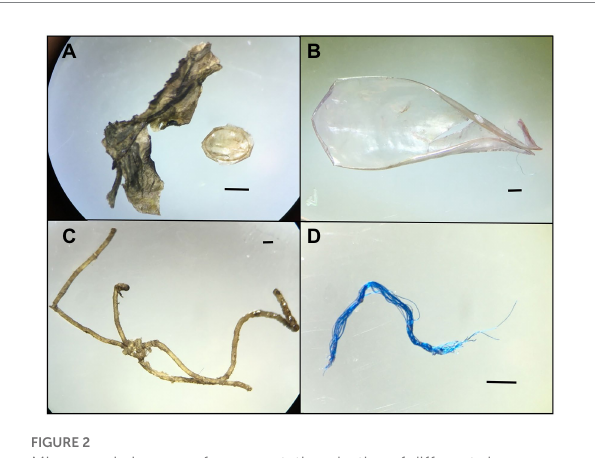
FIGURE 2 Microscopic images of representative plastics of different shapes collected from the GI tract of manatees (A) Fragment, two different particles, (B) Sheet, (C) Monofilament Line Fiber and (D) Fiber. Scale bar = 1 mm.